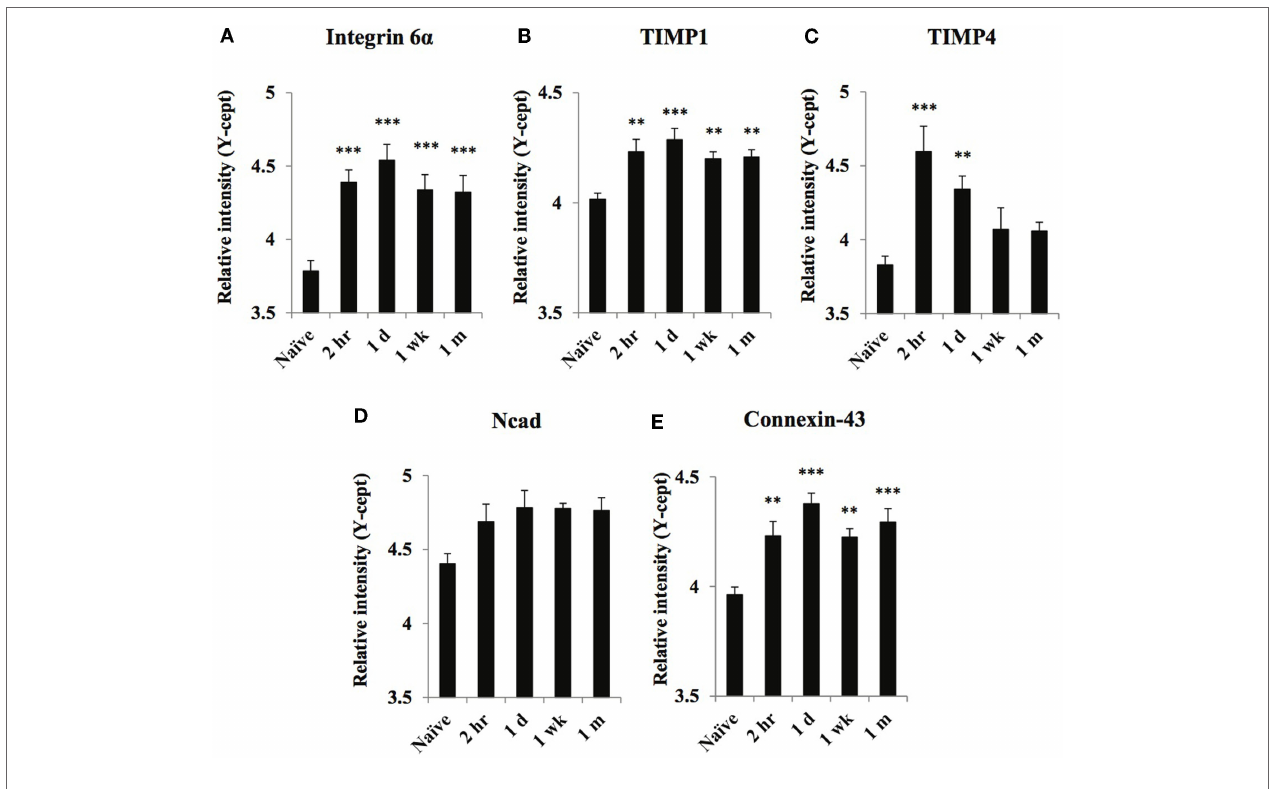
TIMP1 (B) , TIMP4 (c) , Ncad (D) , and Connexin-43 (e) were assayed using reverse phase protein microarray (RPPM) and are expressed as y -cept values (log 10). Data are presented as the mean ± SEM; ** p < 0.01, *** p <